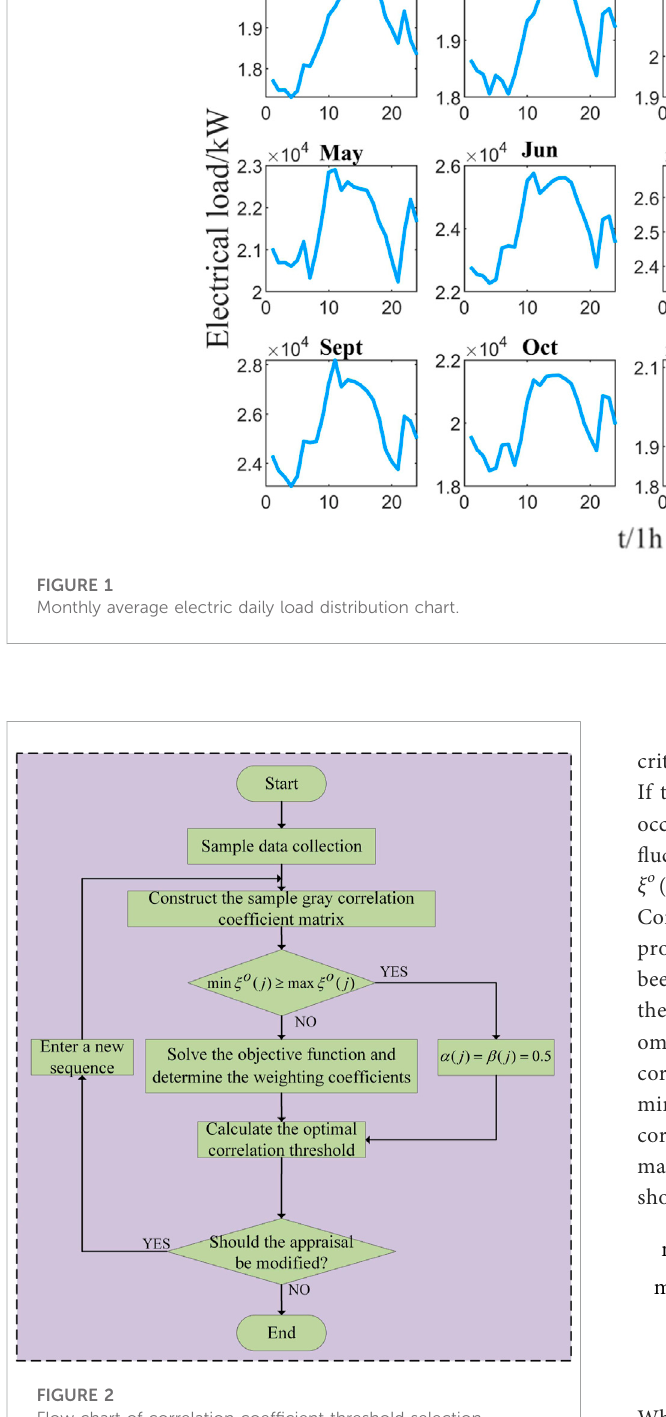
FIGURE 2 Flow chart of correlation coef fi cient threshold